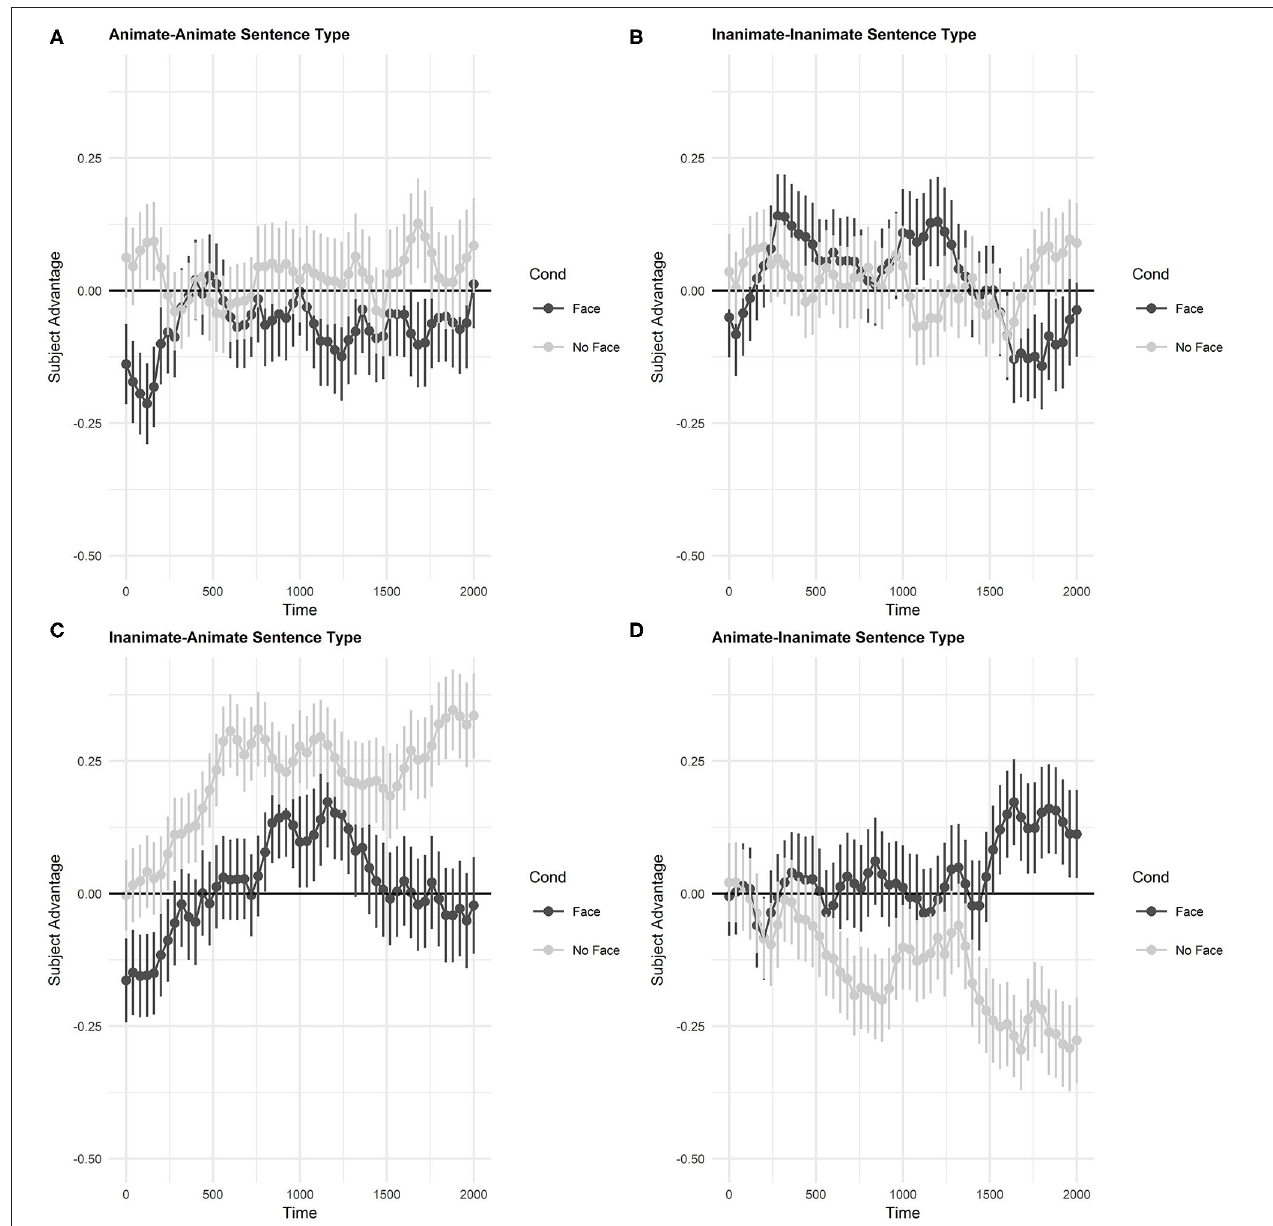
FIGURE 6 | Adult proportional eye tracking data by sentence type and image condition. Subject Advantage values represent looks to the subject interest areas minus looks to the object interest areas. Error bars represent standard error. (A) Animate-animate sentence type. (B) Inanimate-inanimate sentence type. (C) Inanimate-animate sentence type. (D) Animate-inanimate sentence